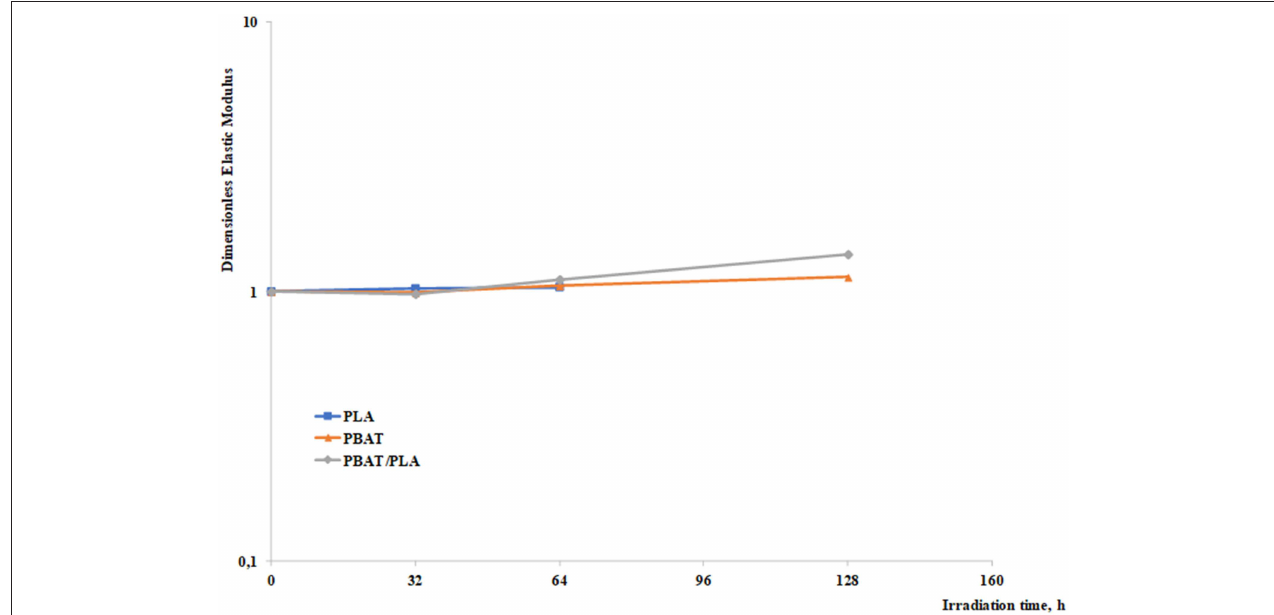
FIGURE 6 | Dimensionless elastic modulus as a function of the irradiation time.